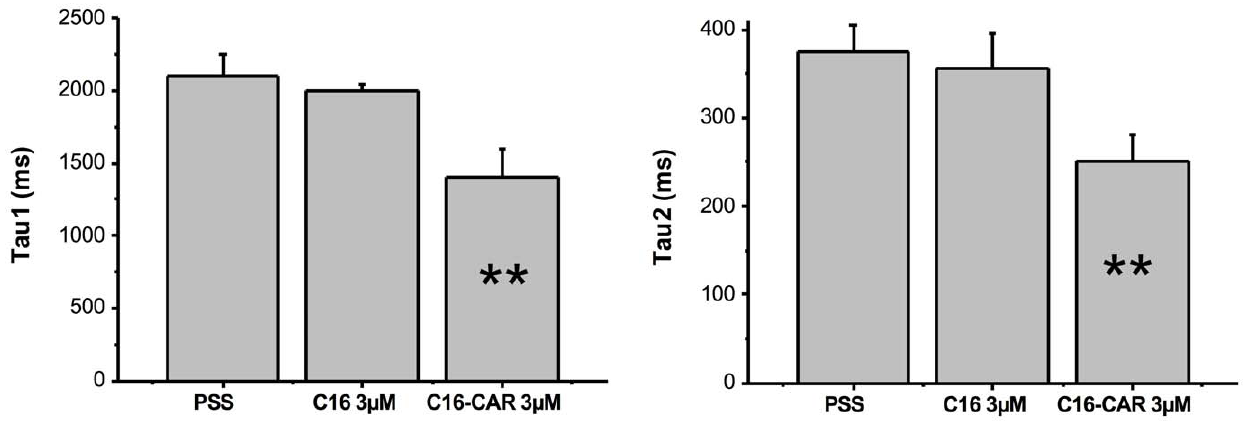
Figure 5. The effect of extracellular C16 or C16-CAR on deactivation kinetics of I hERG , when membrane potential returned to 2 55 mV from a 5sto 2 10 mV. ** p , 0.01.